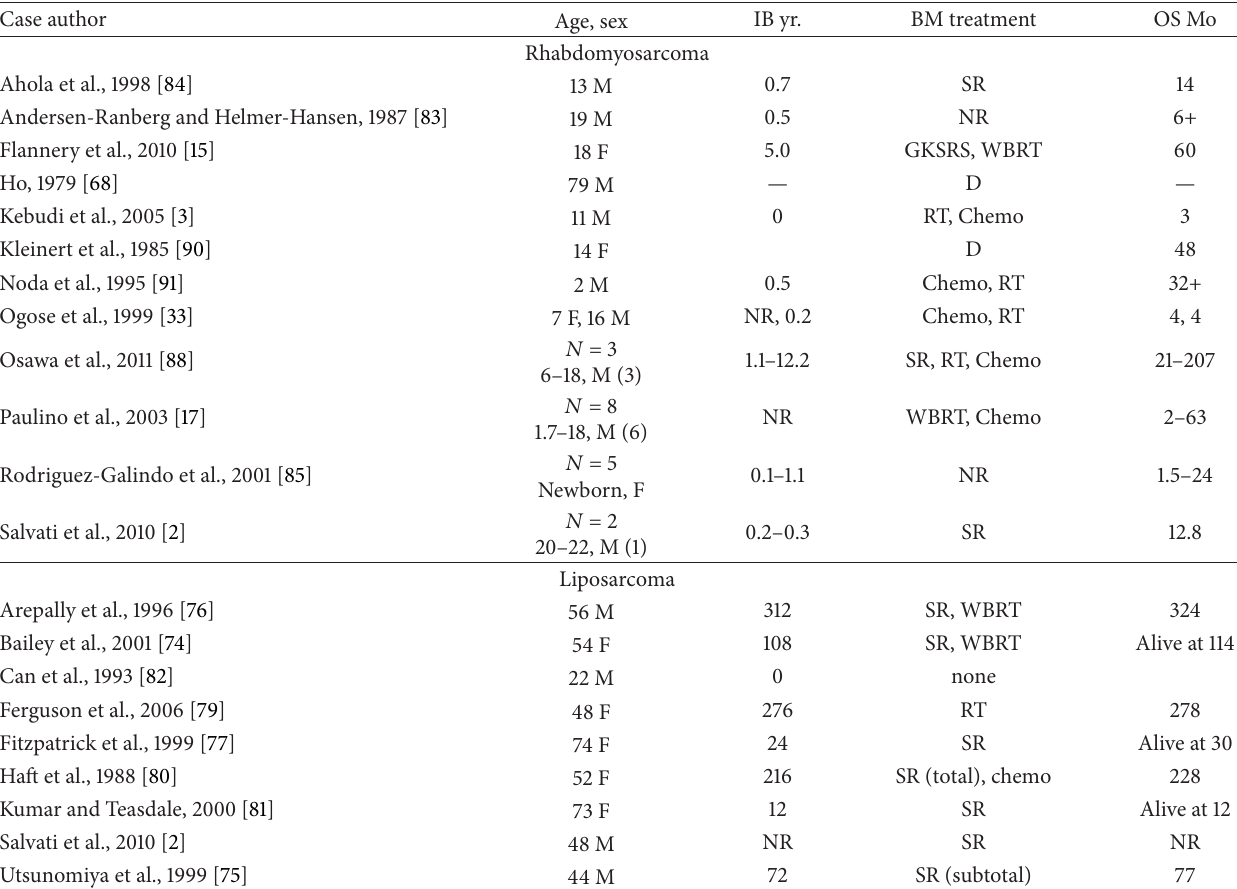
Table 5: Comparison of published reports detailing characteristics of patients with brain metastases from liposarcoma and rhabdomyosar-